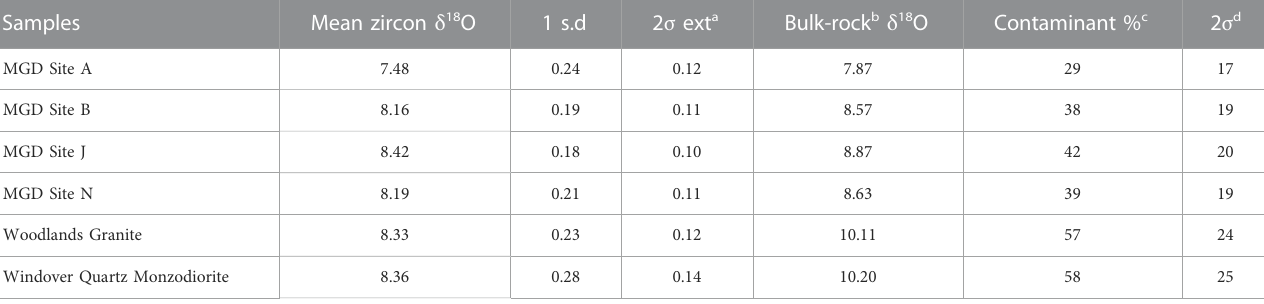
TABLE 4 Oxygen isotope compositions of zircon populations and bulk-rock samples, and the percent of contaminant present in the sample assuming binary mixing.